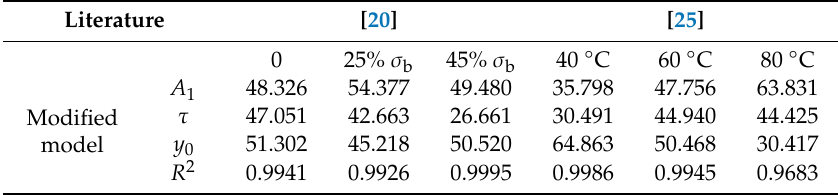
Table 4. Fitting equation coe ffi cient of modified model with experimental values in [20,25].